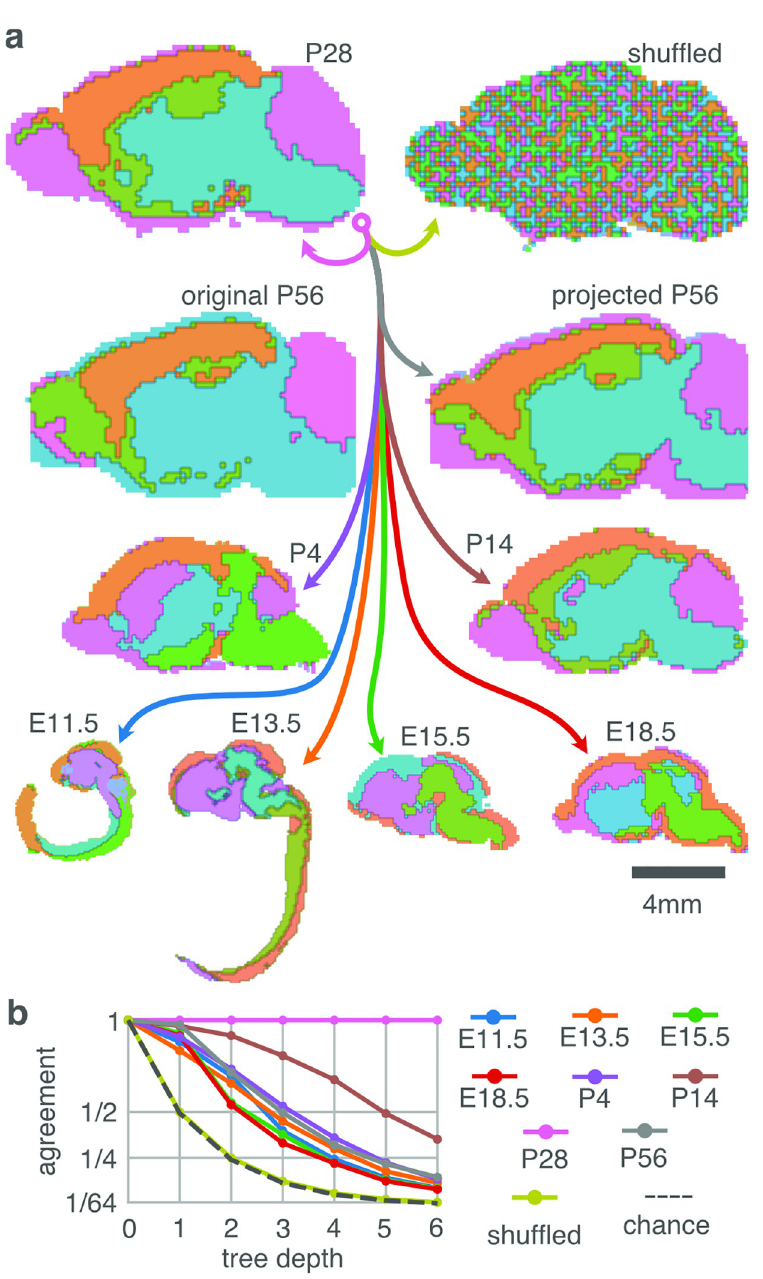
Fig 6. The root asymmetry measured at P28 is projected to the other available embryonic and post-natal developmental time points, and compared to the root asymmetry measured at the respective time point. A First division of the hierarchy, but the direction of variance used to sort the bins is derived from P28, rather than from the data of the time point itself (except Original P56). This temporally projected pattern only has small differences with the patterns derived from the original data (compare Original P56 to Projected P56). When the expression data is shuffled over voxels and genes, maintaining pooled expression statistics but destroying covariance structure, all spatial patterning disappears. Images are proportional to their actual brain sizes. B Quantification of the agreement between the original and projected hierarchy, measured as the proportion of voxels in matching bins, at different levels in the hierarchy. (Although the images in A are 2D, quantification is done on the 3D voxels.) The number of possible bins grows exponentially with tree depth, and so chance level decreases inverse-proportionally (dashed line), quantitatively verified by the shuffled case (yellow line). P28 projects onto itself, and is hence in perfect agreement. The other time points show an agreement consistently above chance. Consider that a mismatch at a shallow depth cannot be corrected at a deeper depth, and so mismatch can only